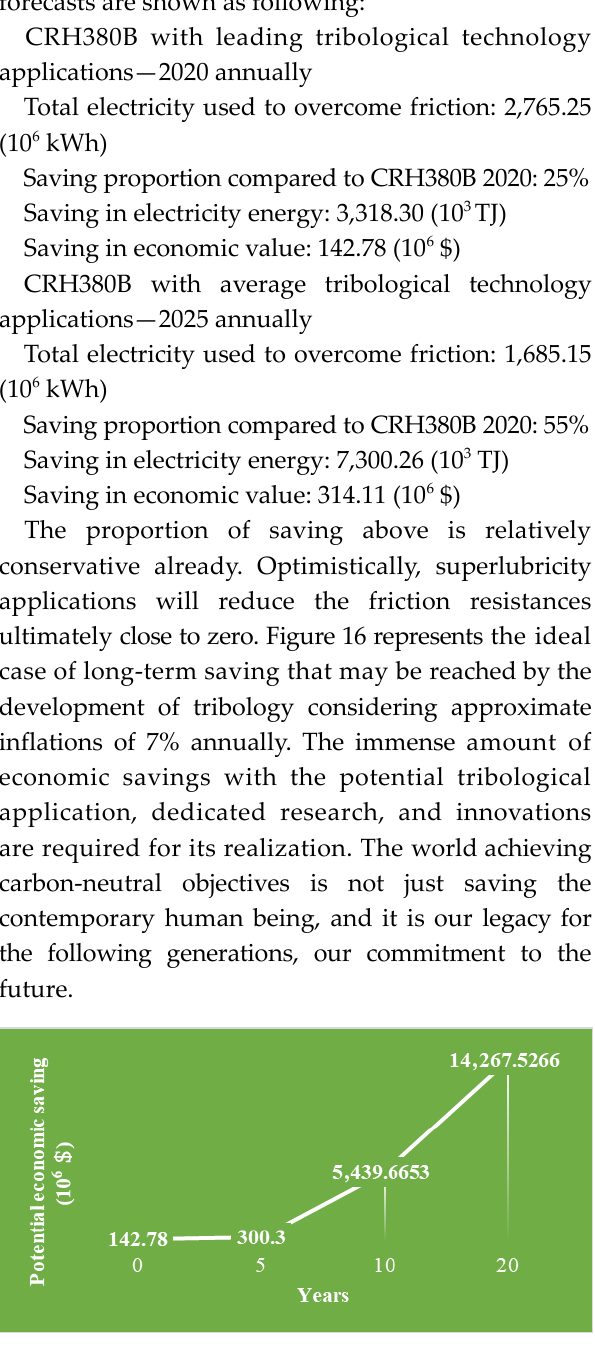
Fig. 16 Potential economic savings by advanced tribology applications in CRH by time